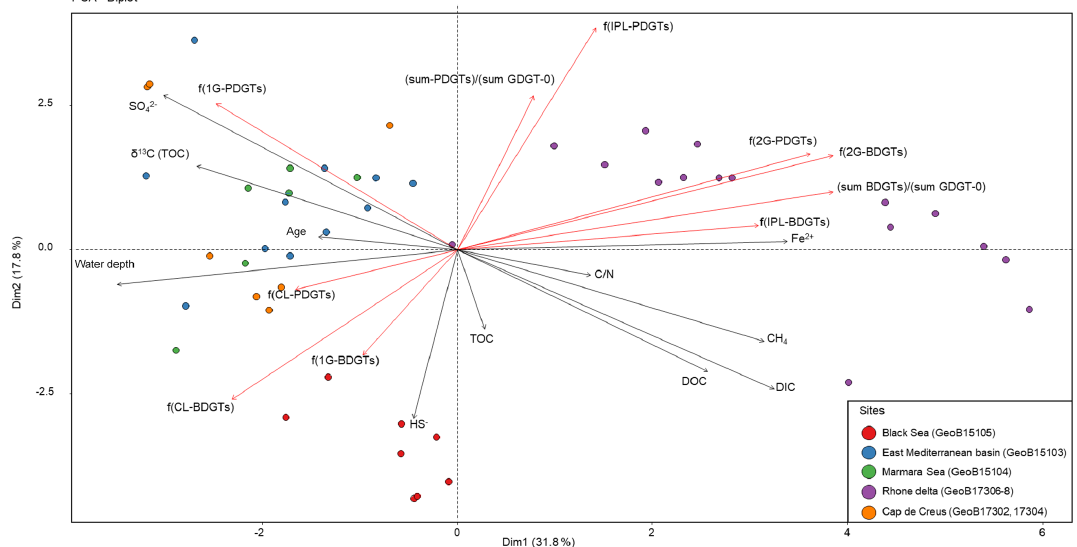
Figure 4. Principal component analysis biplot showing relationships between major geochemical parameters (grey arrows), indices illus- trating BDGT and PDGT distribution (red arrows), and 45 sediment samples (filled circles) from the Mediterranean and Black seas where BDGTs and PDGTs were detected.